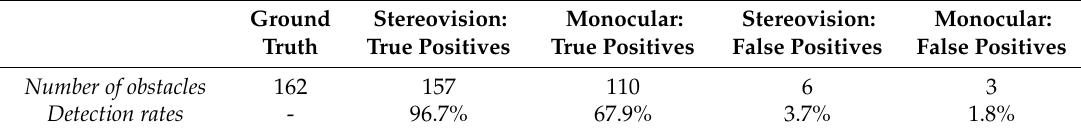
Table 4. Detection rate comparison between the monocular approach and stereovision. Ground Stereovision: Monocular: Stereovision: Monocular: Truth True Positives True Positives False Positives False Positives Number of obstacles 162 157 110 6 3 Detection rates - 96.7% 67.9% 3.7% 1.8%